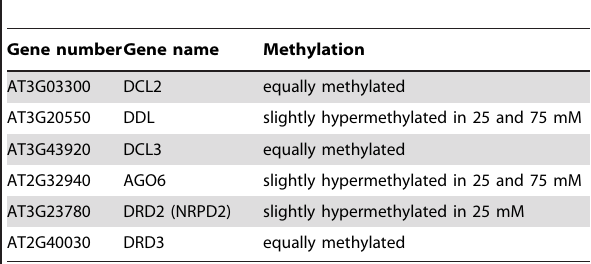
Table 6. Methylation in genes encoding proteins involved in siRNA